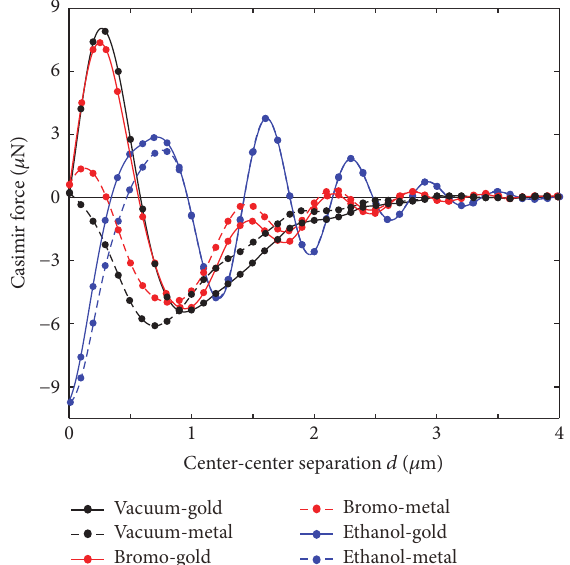
Figure 2: Casimir force for ellipsoid-plate geometry with perfect metal and realistic gold in three different mediums, including vac- uum,bromobenzene,andethanol;negativesignrepresentsrepulsive force. For 𝑑 > 3.5 𝜇 m, forces are close to 0.